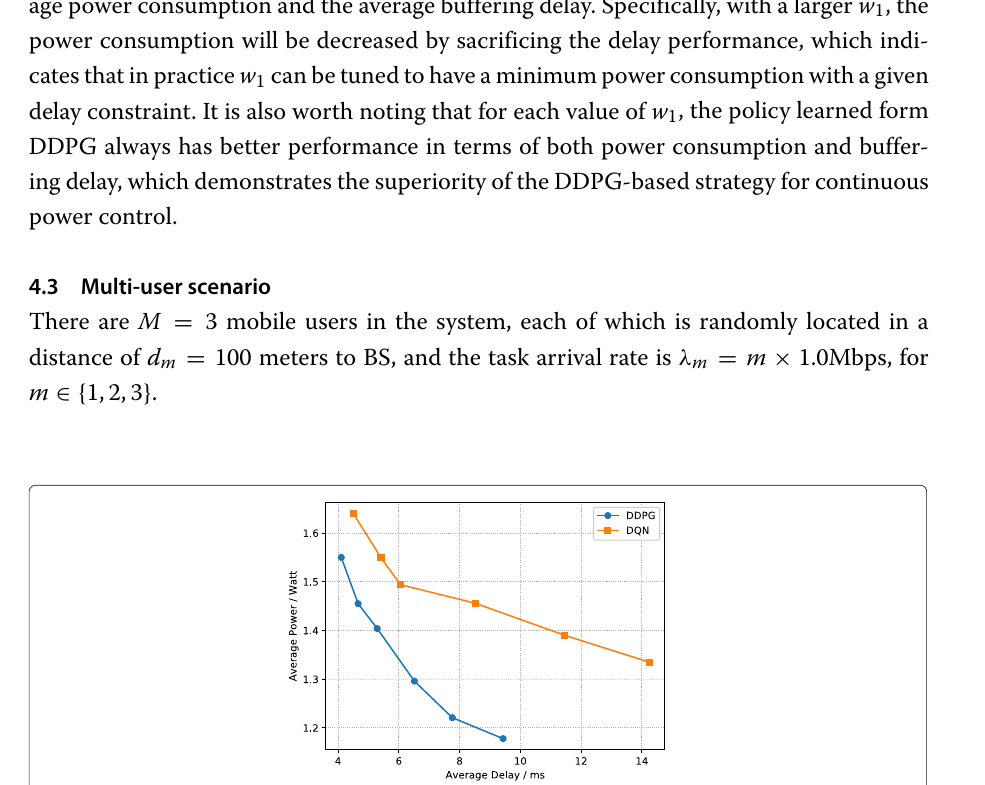
Fig. 8 Illustration of power-delay tradeoff for a single user agent with λ 1 = 3.0Mbps. Note that for the points oneachcurvefromlefttoright,thetradeofffactor w 1 variesfrom0.3 ∼ 0.8,correspondingly.Noticethatthere is no trade-off curve for these two greedy algorithms, since they are not impacted by the tradeoff factors. The power-delay points for GD-offload and GD-local are located at ( 1.85,3.148 ) and ( 1.91,3.147 ) ,